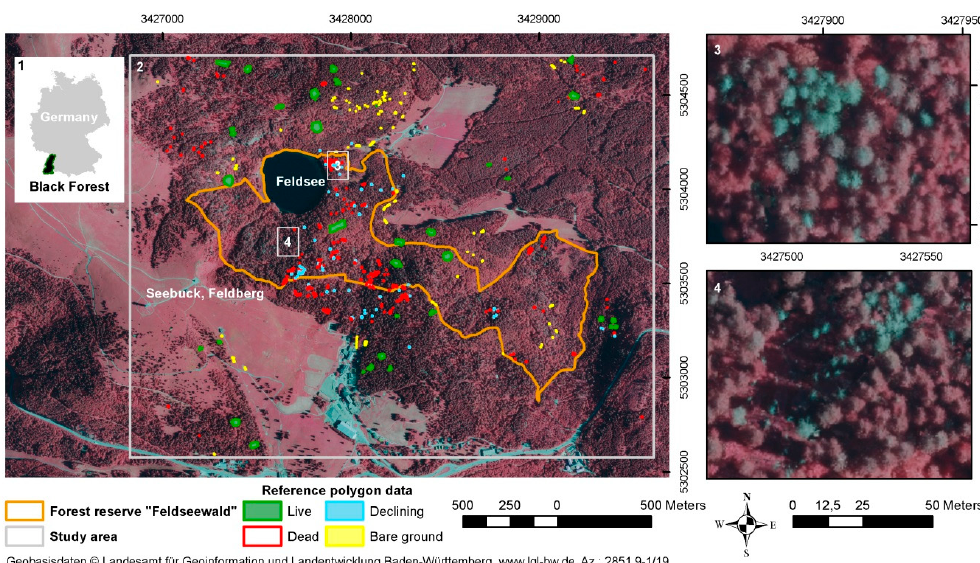
Figure 1. Location of the Black Forest in Germany. ( 1 ) Study area ( 2 ) with the lake “Feldsee”, the second top of Feldberg mountain “Seebuck” (1448 m a.s.l.), the “Feldseewald” strict forest reserve and the reference polygons for the four classes (“live”, “dead”, “declining”, and “bare ground”, see Figure 2) on the background of the color-infrared (CIR) orthophoto. Examples of standing dead trees ( 3 , 4 ) and snags ( 4 ).